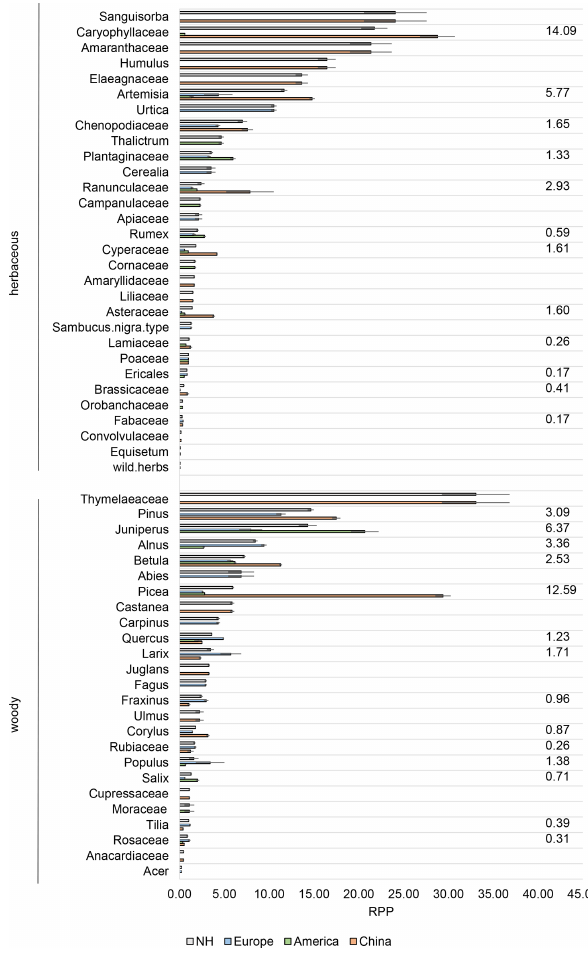
Figure 2. Relative pollen productivity (RPP) dataset v1 including all continental mean RPP values with their standard error (SE), cal- culated with the delta method (see Sect. 2). Numbers to the right are the standard deviation (SD) between continental datasets, NH is Northern Hemisphere.